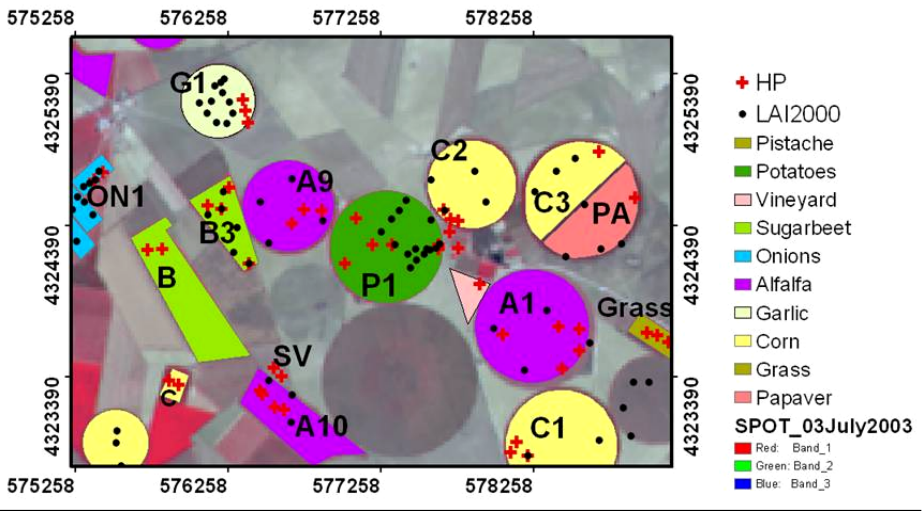
Figure 4. Land use map for the Barrax test site. Red crosses indicate the points where hemispherical photographs (HP) were